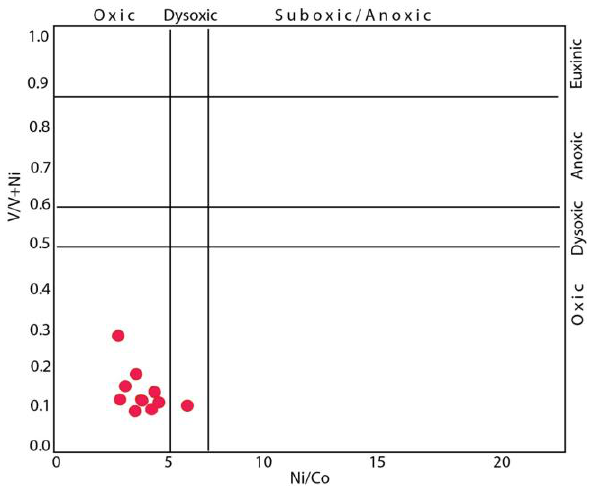
Figure 9. The V/(V+Ni) vs. Ni/Co trace element ratios of stromatolites to find the redox conditions [78]